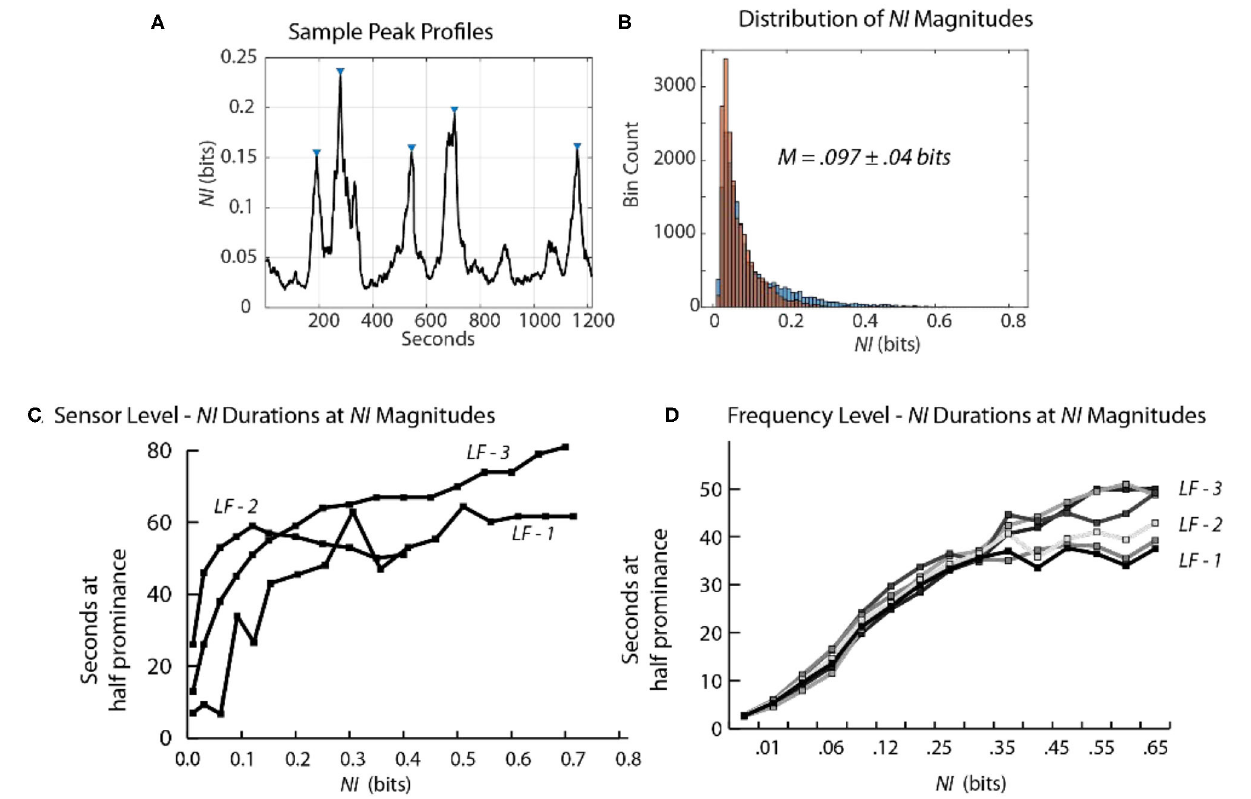
FIGURE 9 | Relationship between the magnitude and duration of NI peaks. (A) A segment of a Life Flight team NDS showing peak identifications, using the findpeaks.m MATLAB® function. The peak magnitudes resulting from this function are based on having a minimum level of magnitude, which was 0.1 bits for this plot. (B) The second-by-second NI distributions from the 19 sensors of the FN-H and FN-S of LF2. (C) This plot shows the duration of peaks (y-axis) within different magnitude intervals (x-axis). (D) The duration of peaks is shown for the six team members when the data streams included the 1–40Hz frequency bands of each